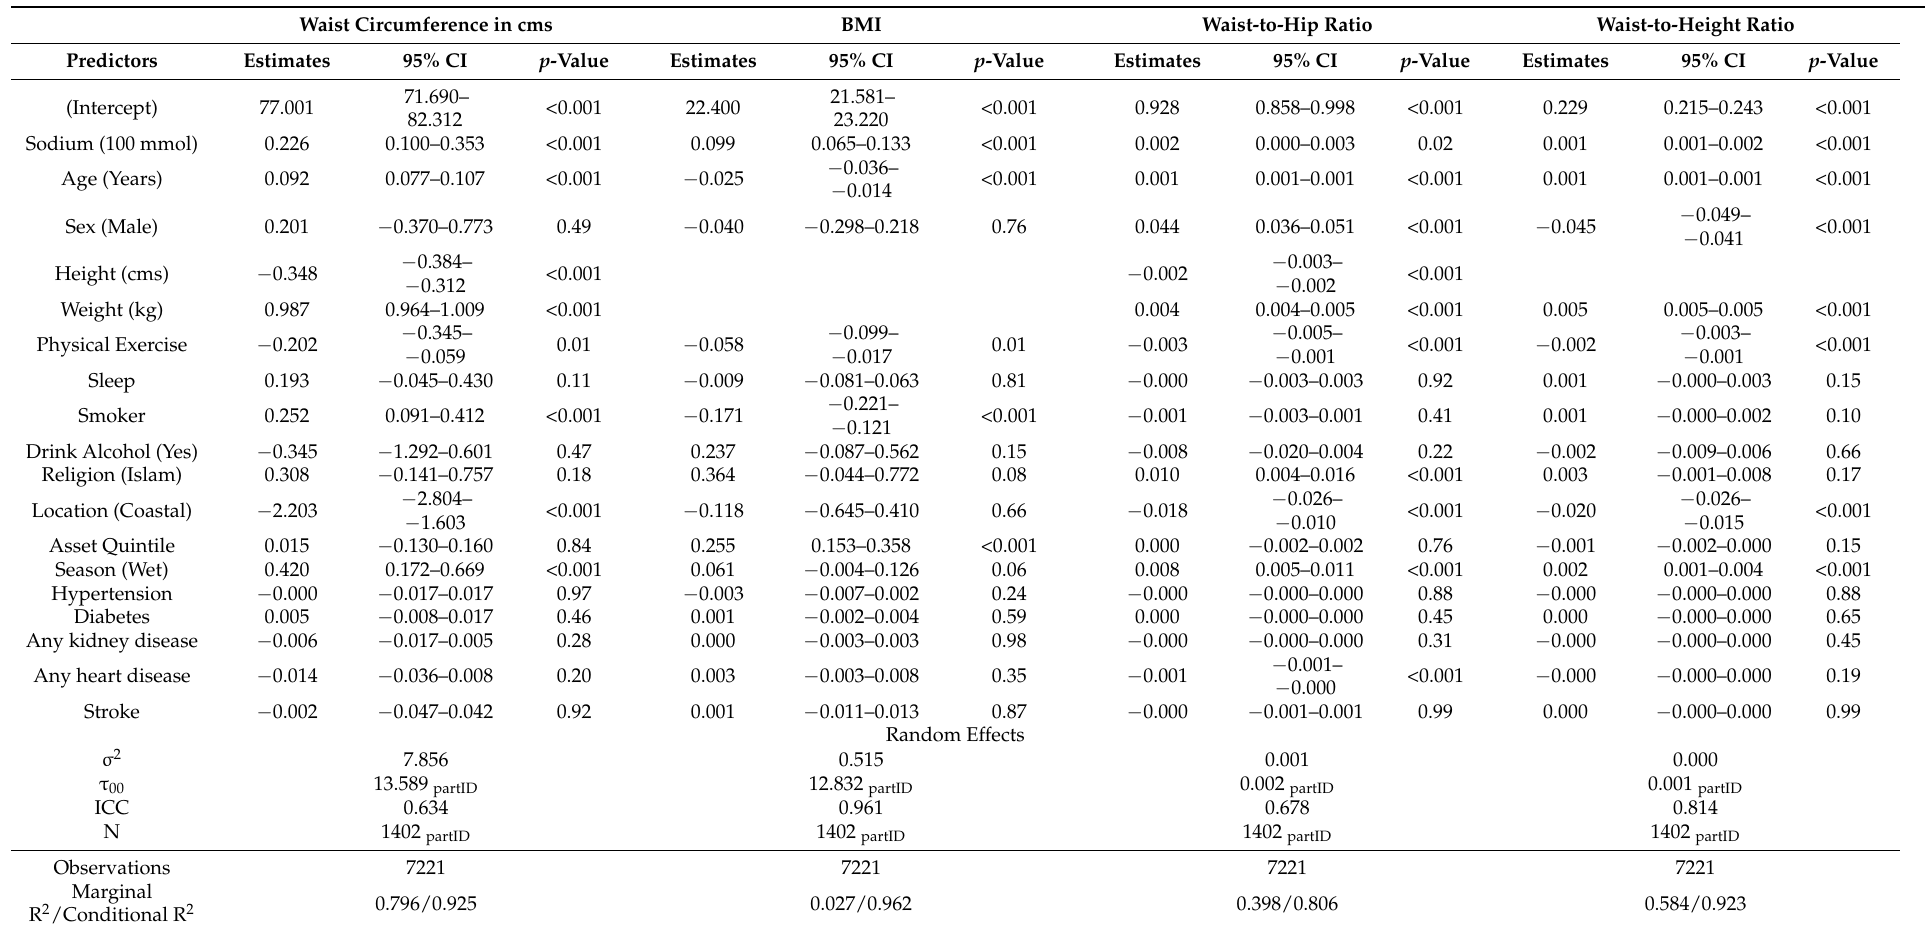
Table 12. Association between 24 h urinary sodium and mean waist circumference, BMI, waist-to-hip ratio, and waist-to-height ratio among complete 24 h urine samples based on criteria creatinine index